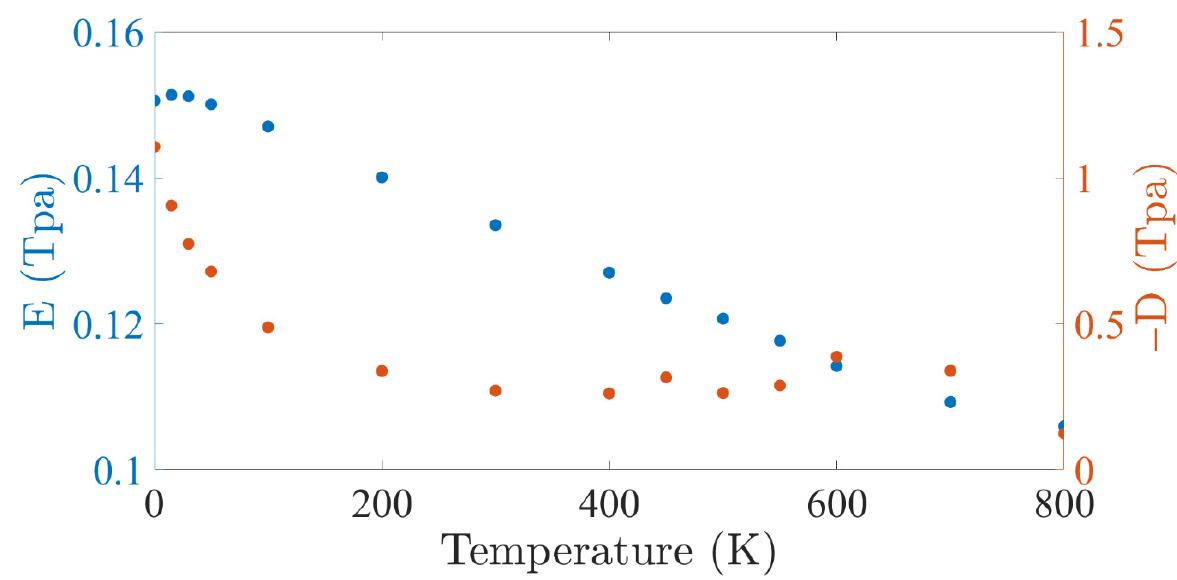
Figure 11. E and D were obtained from the MD simulation results for different